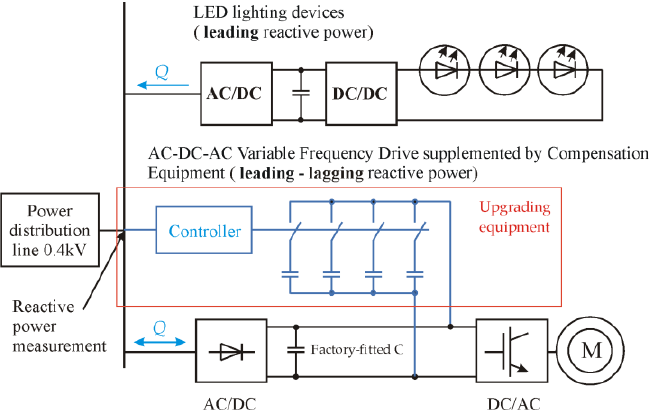
Figure 3. Proposed modernization of the conventional single-phase supply AC-DC-AC VFD for the reactive power compensation in LED-loaded power distribution lines.